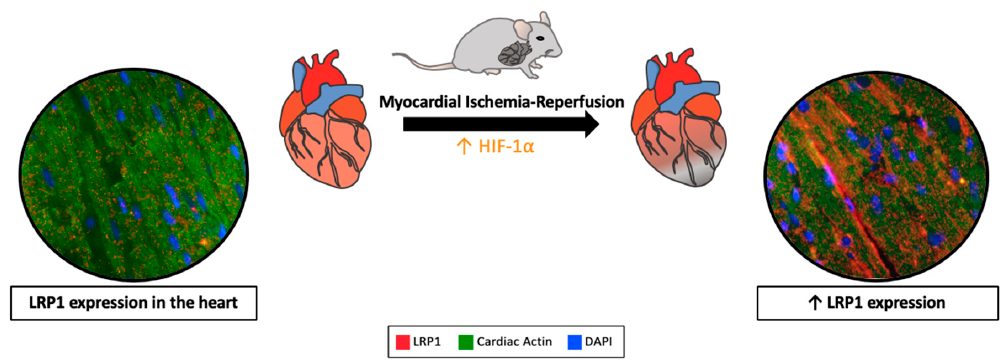
Figure 1. Lipoprotein receptor-related protein 1 (LRP1) expression is increased in the myocardial tissue after ischemia-reperfusion. Hypoxia upregulates LRP1 expression through induction of the hypoxia-inducible factor-1 α (HIF-1 α ) in cardiomyocytes.